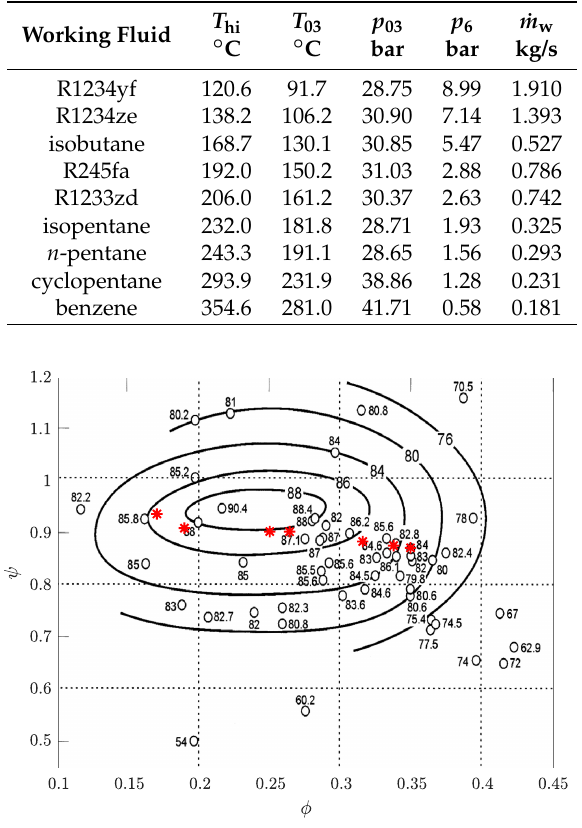
Figure 12. Comparison between the optimal turbine designs (red markers) and other turbine designs (white circles) reported within the literature in terms of the blade-loading coefficient ψ and the flow coefficient φ ; original plot taken from Ref.